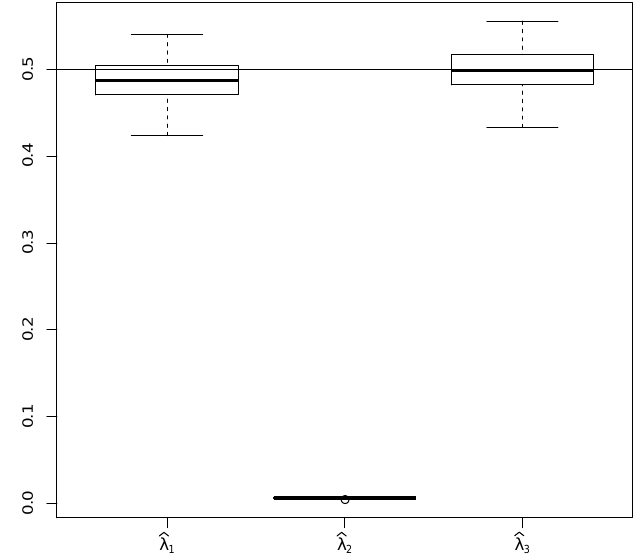
Figure 2. Comparison of (cid:98) λ 1 , (cid:98) λ 2 and (cid:98) λ 3 for 100 trajectories, where H = 0.6, x 0 = 100, T = 10, h = 0.1, σ = 2; the horizontal line shows the true value of the estimated parameter λ =